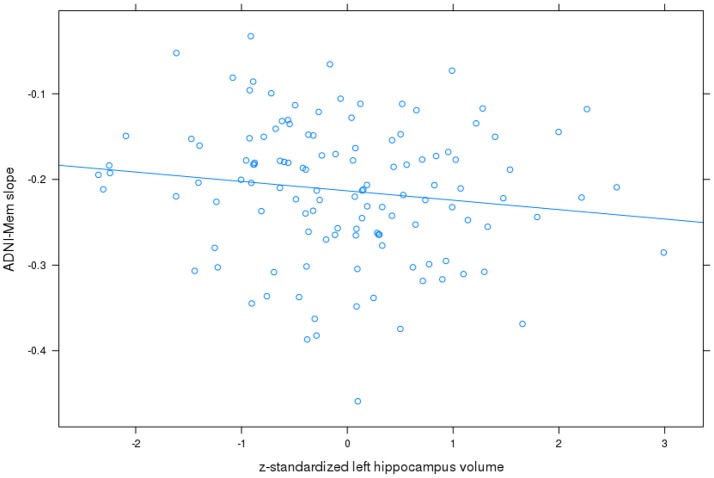
Left hippocampus volume and rates of change in ADNI memory score. Plot of z-standardized left hippocampus volume on mixed effects linear model estimates of rates of change in ADNI memory (ADNI-Mem) score controlling for age and sex, with linear regression line.